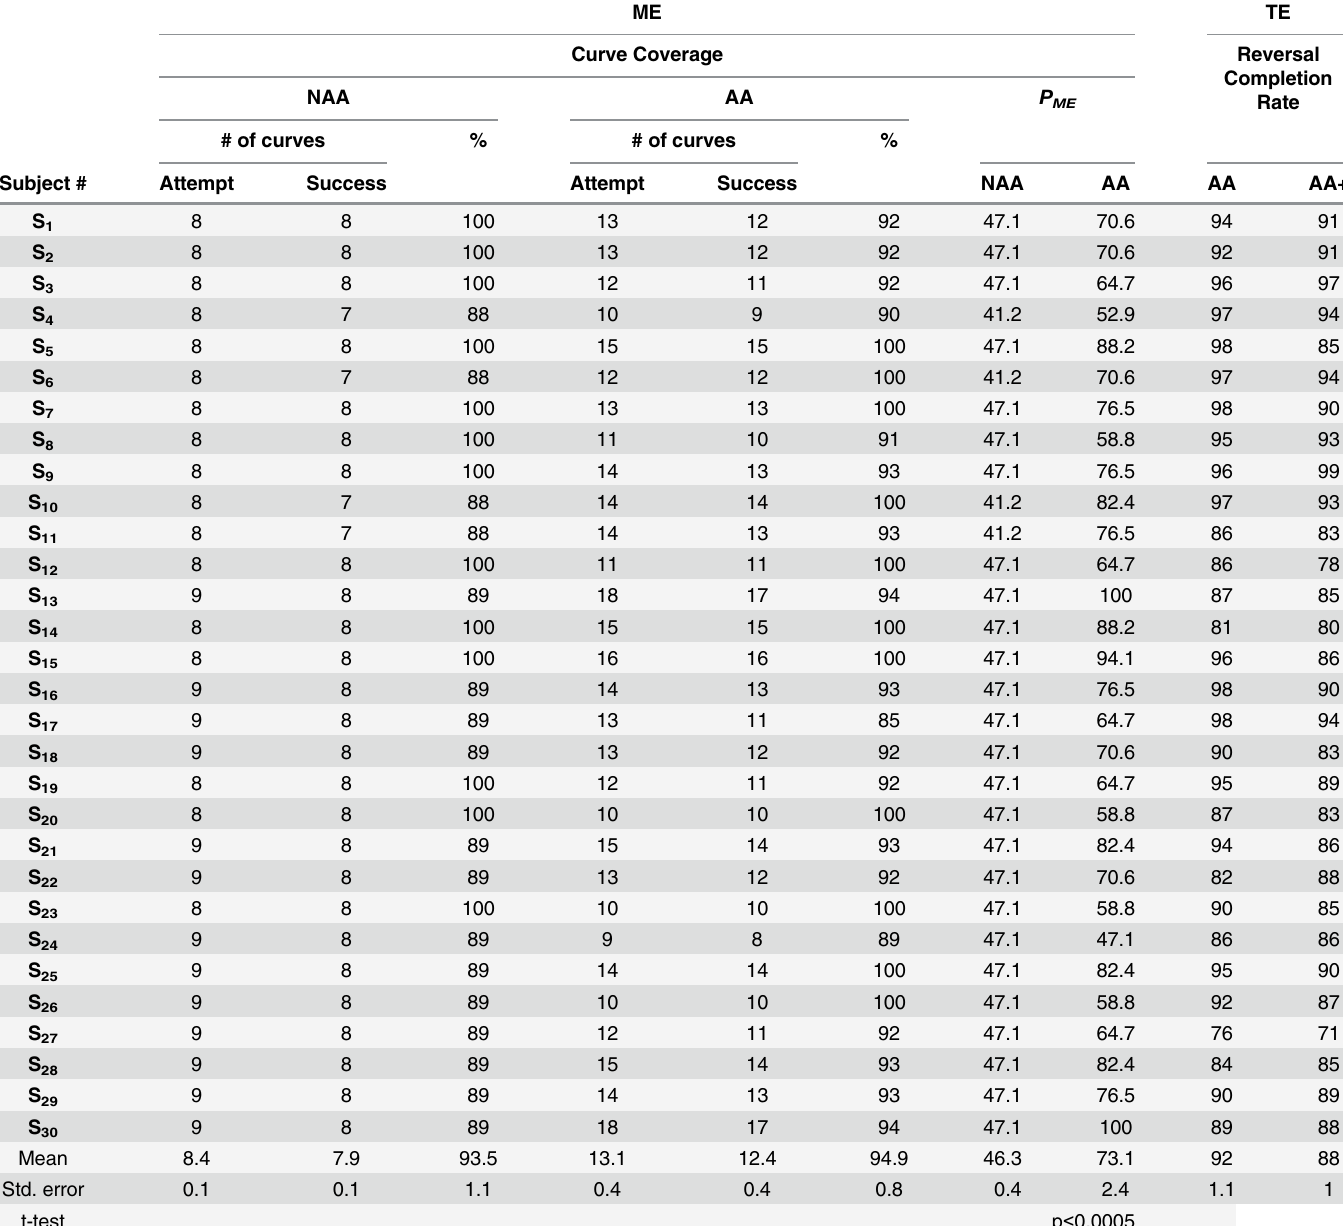
Table 1. Performance in ME and Reversal Completion Rate in